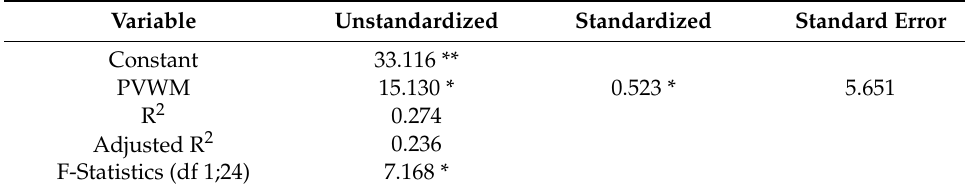
Table 7. Multiple regression analysis with FMT two years after cochlear implantation in the mid-age group as a dependent variable. * p < 0.05; ** p < 0.01.